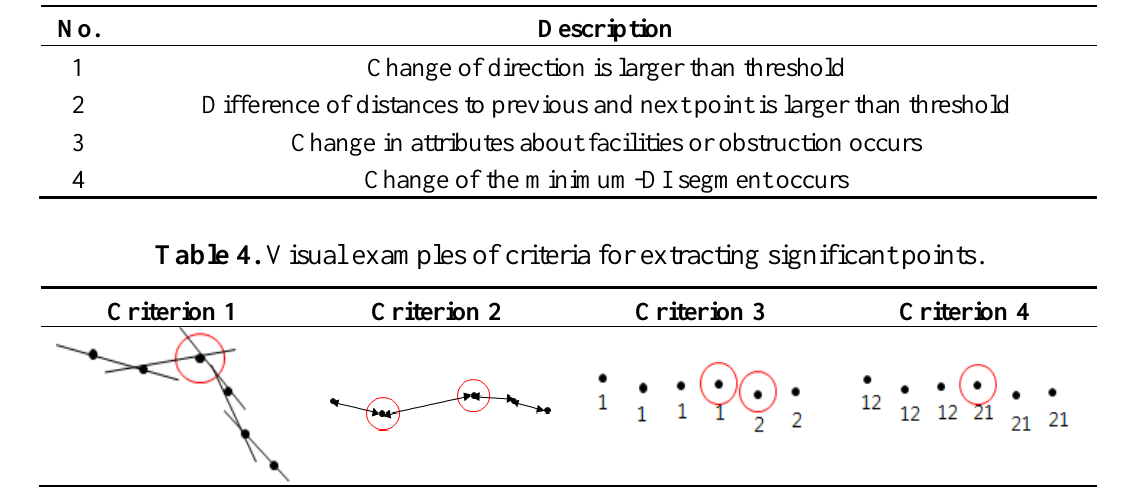
Table 3. Four criteria for extracting significant points from GPS point data.